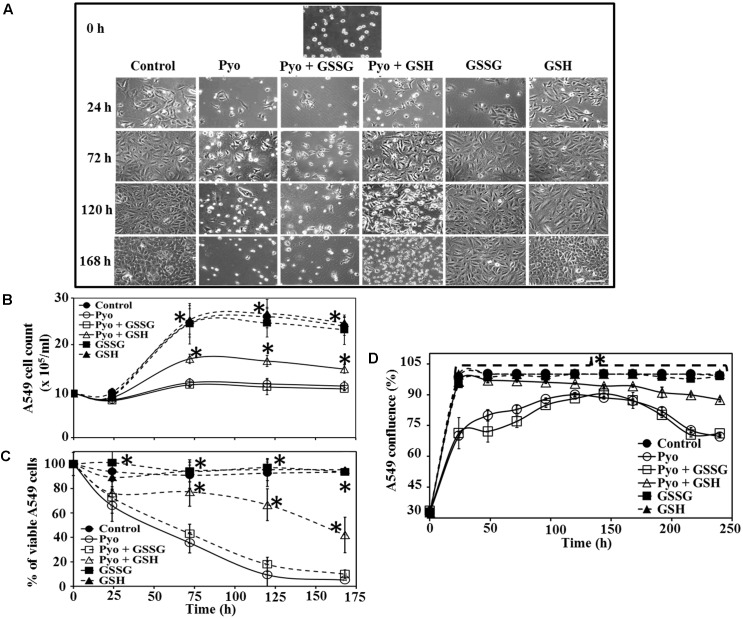
Effect of pyocyanin, GSSG, and GSH on A549 cell growth and confluence over different time periods (A). A549 adherence and confluence in six-well plates at 24, 72, 120, and 168 h post-treatment, with example of adherence at 0 h. Pyocyanin considerably reduced the confluence of A549 and pyocyanin + GSSG did not increase A549 confluence; however, addition of pyocyanin + GSH resulted in an increase in A549 confluence. GSSG or GSH alone resulted in A549 confluence similar to that of the control. Scale bar = 50 μm. (B) A549 cells exposed to pyocyanin showed a significant decrease in cell number, to a level similar to that of pyocyanin + GSSG, while pyocyanin + GSH showed a significant increase in cell number, but still lower than the untreated control, GSSG and GSH-alone. (C) Resazurin assay showed pyocyanin exposed A549 cells rapidly decreased in viability to a level similar to pyocyanin + GSSG, whereas, A549 cells treated with pyocyanin + GSH showed a significant increase in viability. The percentage of live/respiring cells remained at more than 90% for untreated control, GSSG and GSH alone, from 0 to 168 h. (D) The percentage of A549 confluence over the 240 h period showed a significant increase in confluence for the control, GSH and pyocyanin + GSH-cells compared to pyocyanin alone and pyocyanin + GSSG, at all time-points. (B–D)
∗P < 0.05 compared to A549 grown in presence of pyocyanin and pyocyanin + GSSG. Data represent mean ± SD; n = 3 experiments performed in biological replicate.